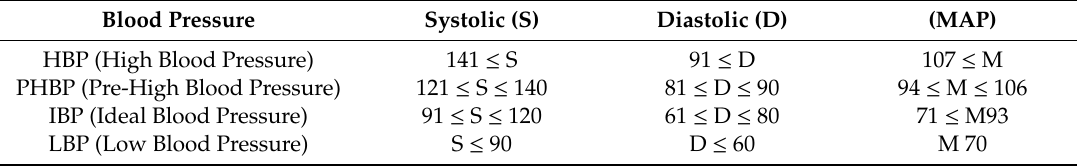
Table 2. Overview of the international blood pressure standards.